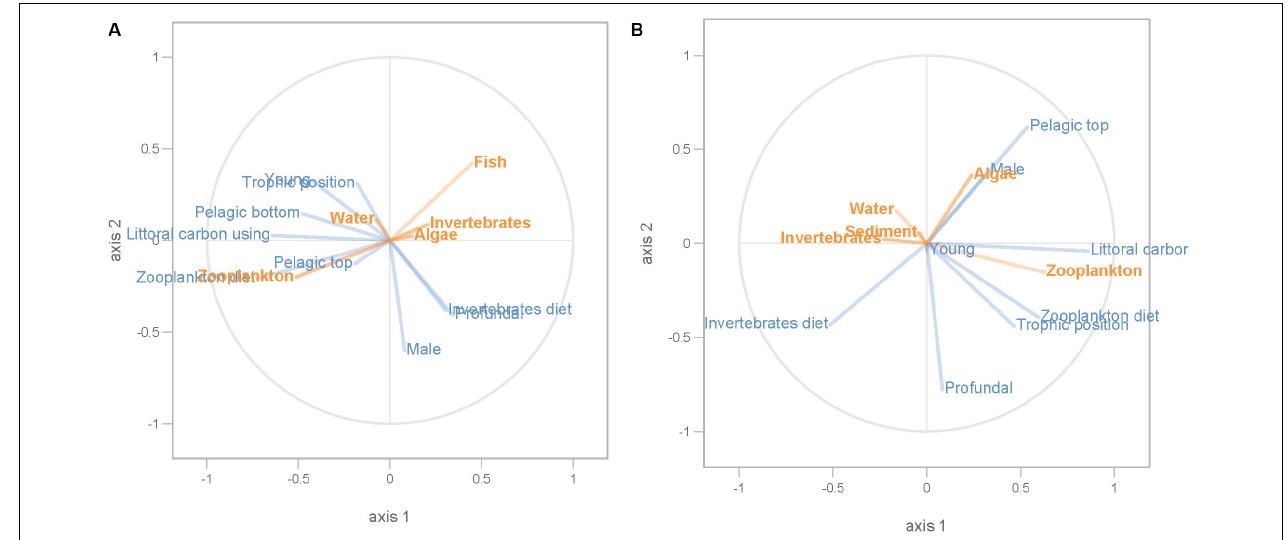
FIGURE 8 | PLS regression analysis between environmental and dispersal factors. Dispersal factors were used as response variable (orange lines), whereas environmental factors were used as predictor variables (blue lines) in perch (A) and roach (B) .